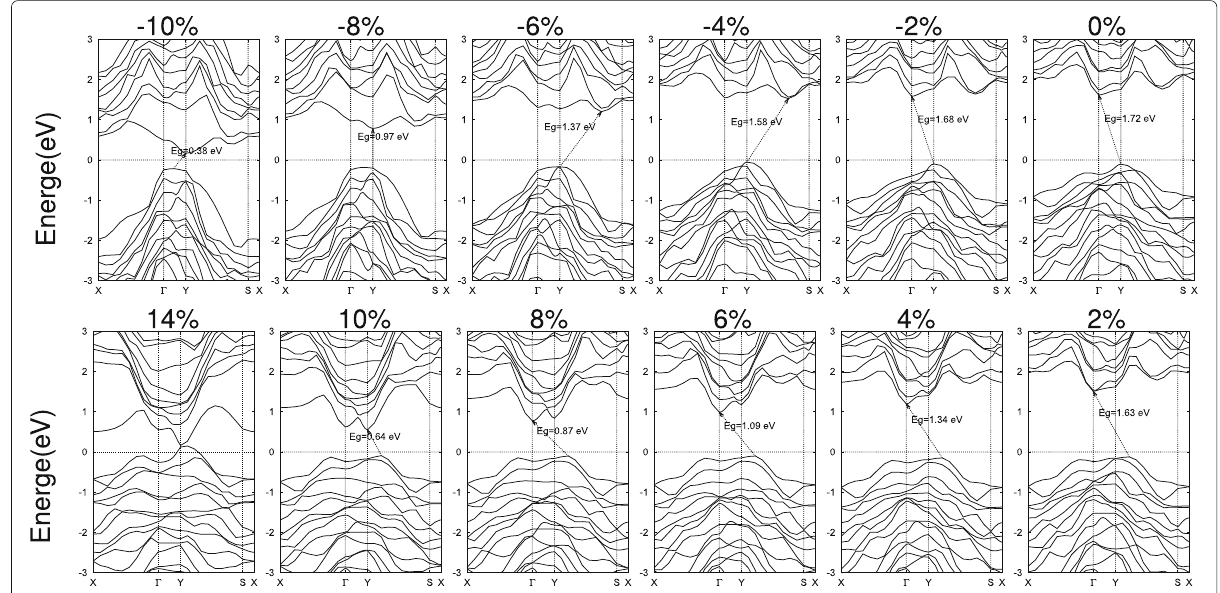
Fig. 6 Band structures of 2D SiAs under the biaxial strains. The Fermi level is set as zero and indicated with a dot line